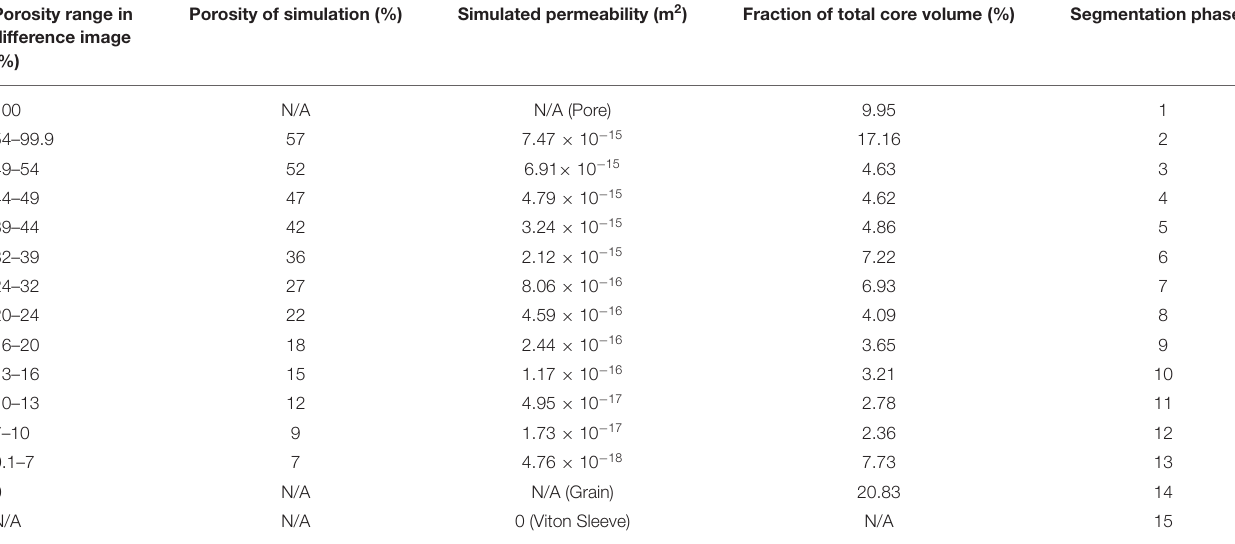
TABLE 1 | Porosity and permeability values for microporosity calculated from numerical simulations on synthetic images. Porosity range in Porosity of simulation (%) Simulated permeability (m 2 ) Fraction of total core volume (%) Segmentation phase difference image (%)